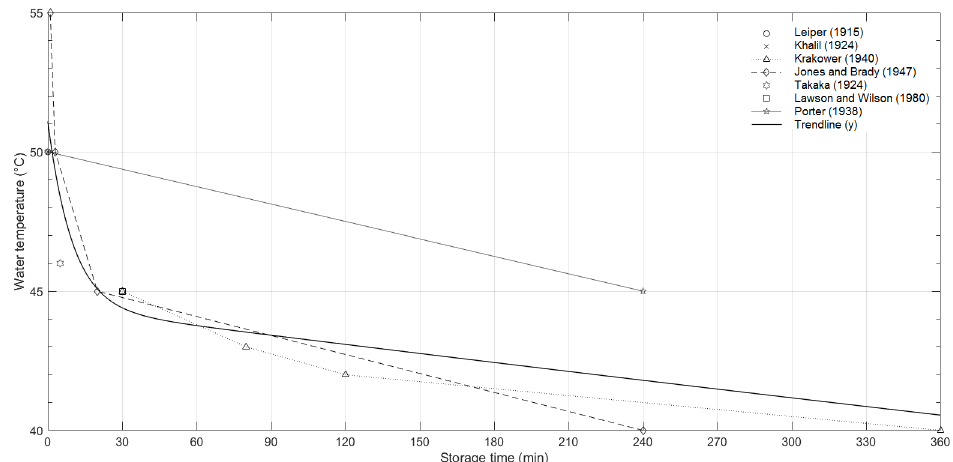
Fig 1. Water temperatures and storage times required to reach zero cercarial survival (measured when all cercariae are immobile). Species are listed in Table